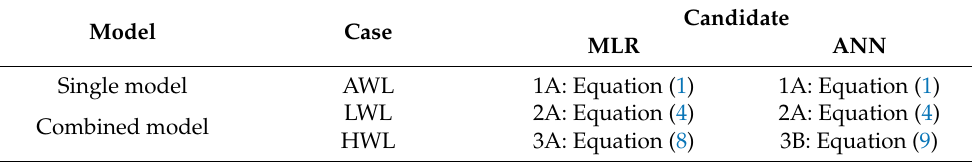
Candidate MLR ANN